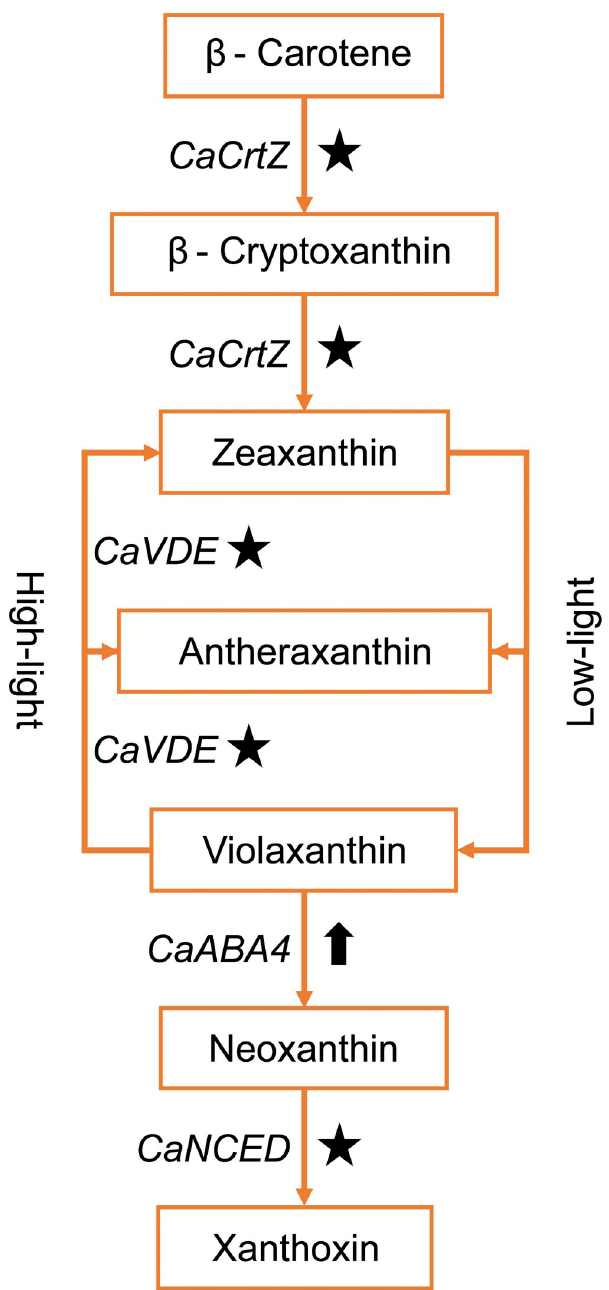
Fig 3. The DEGs involved in the biosynthesis of xanthophylls under blue light. The sub-pathway involved in the biosynthesis of zeaxanthin, neoxanthin, and xanthoxin is obtained from the carotenoid biosynthesis pathway of the KEGG database. The DEG implicated in each step is shown. Star symbol indicates that the expression level under blue light of the corresponding DEG is higher than that under red light. Up-arrow symbol shows that the corresponding DEG is up-regulated under blue light. CaCrtZ : beta-carotene hydroxylase, CaVDE : violaxanthin de-epoxidase, CaABA4 : abscisic acid-deficient 4, CaNCED : 9-cis-epoxycarotenoid dioxygenase.